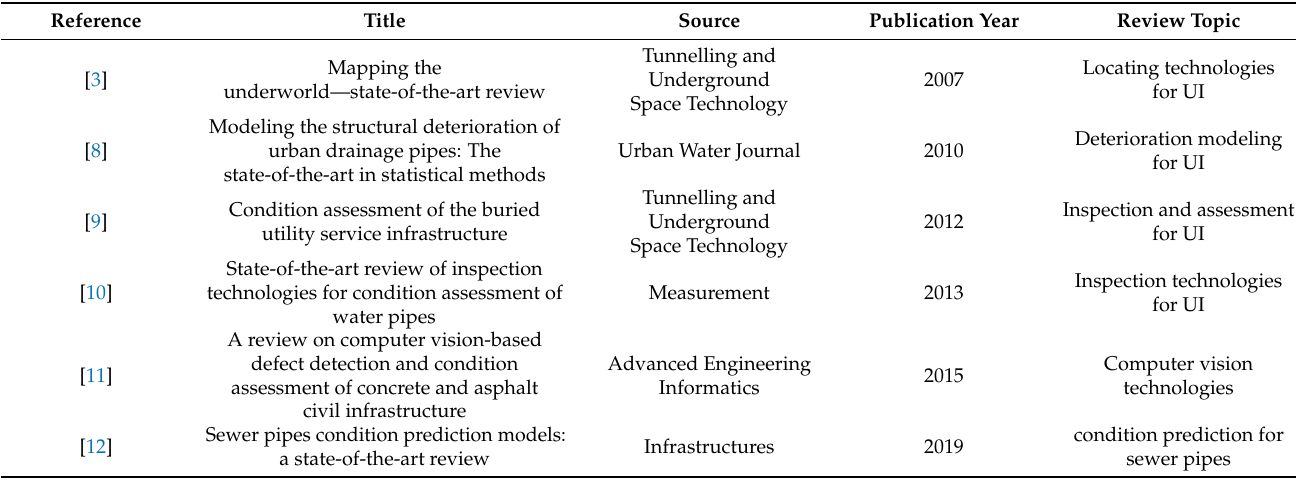
Figure 1. Urban underground infrastructure. Table 1. Related literature review research in the field of UI.